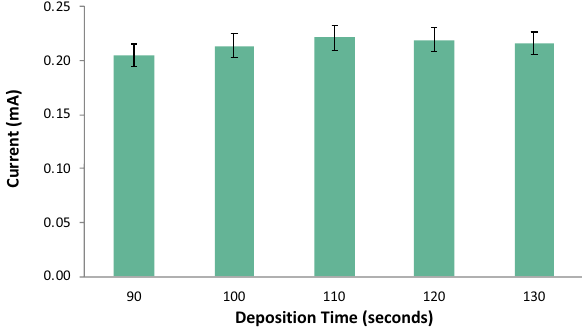
Figure 7. Anodic current peaks for varying deposition time.